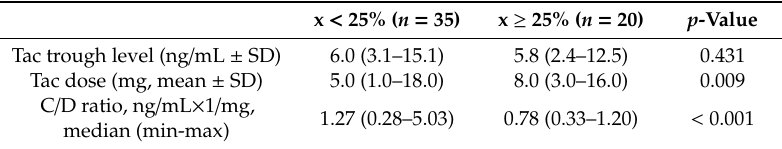
Table 2. Tac trough level and dose of two calcineurin inhibitor toxicity groups.